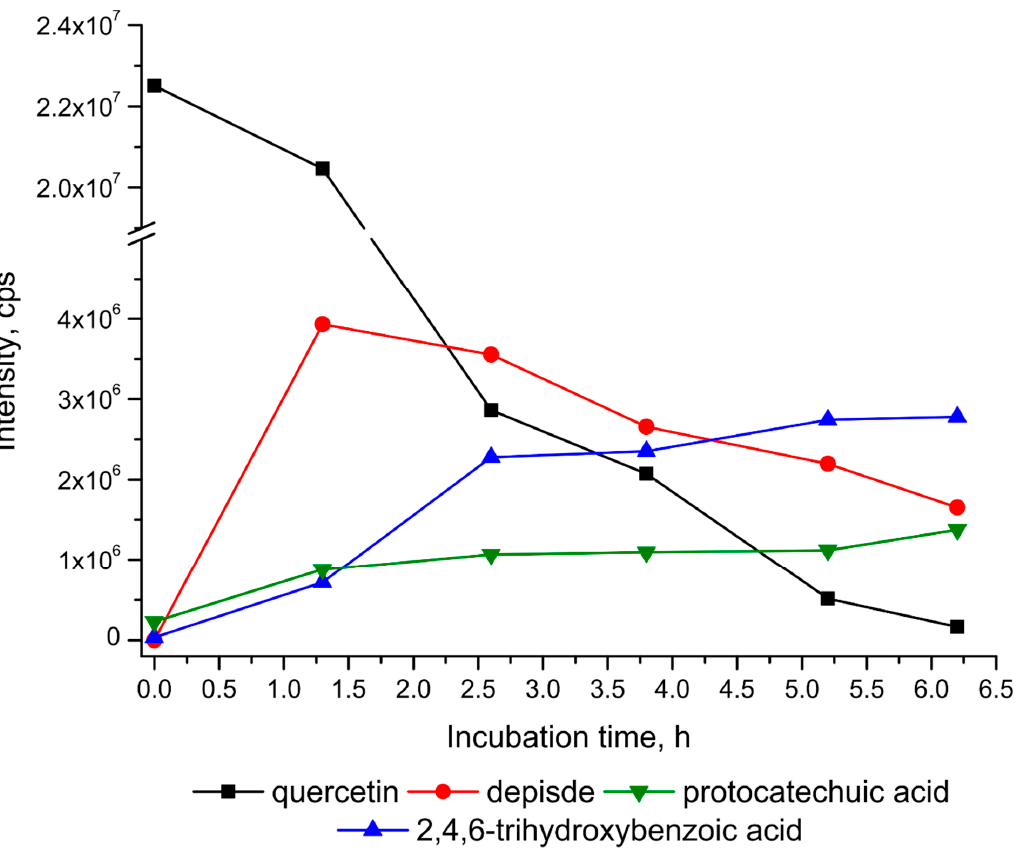
Figure 2. Degradation profile of quercetin and its main products formed during the incubation with H 2 O 2